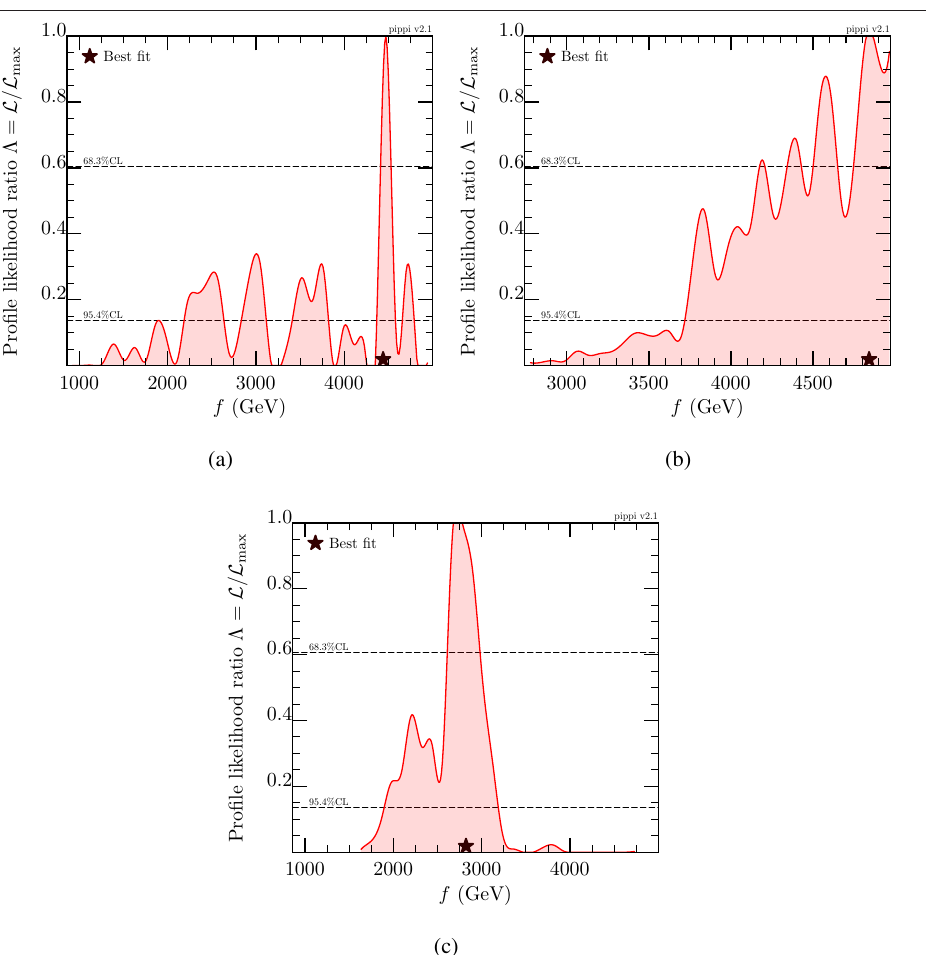
Figure 1: Profile likelihood ratios of the Higgs decay constant f in (a) the M4DCHM 5 − 5 − 5 , (b) the M4DCHM 14 − 14 − 10 , (c) the M4DCHM 14 − 1 − 10 . For reference, the best-fit points